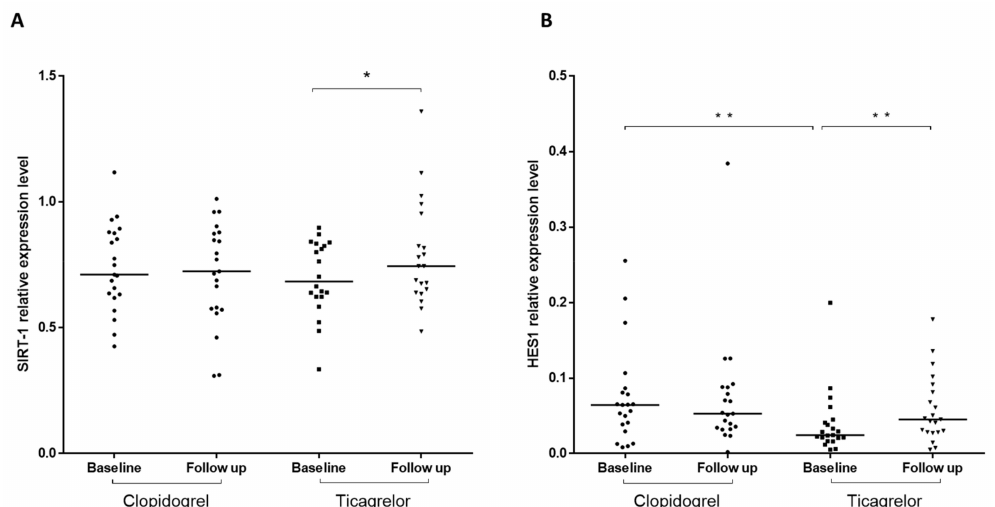
Figure 2. Droplet digital (dd) PCR based analysis of the levels of SIRT1 and HES1 mRNA in peripheral blood cells of stable CAD / COPD patients following 1-month treatment with ticagrelor or clopidogrel. Scatter plots, with medians, of the expression levels of SIRT1 ( A ) and HES1 ( B ) in peripheral blood cells of stable CAD / COPD patients following 1-month treatment with ticagrelor or clopidogrel. The absolute quantity of cDNA (copies / µ L) was normalized to the average number of copies of GUSB . Follow up vs. baseline gene expression values, ANOVA test, * p < 0.05 and ** p < 0.01. Comparison of gene expression levels at baseline, student t test, ** p < 0.01.